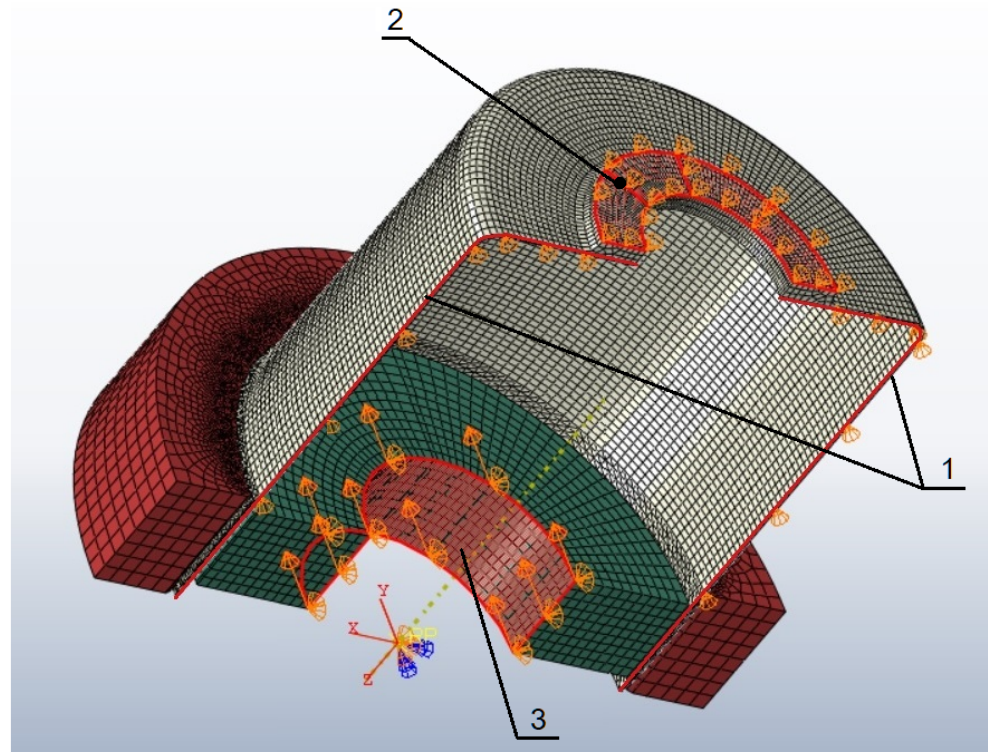
Figure 4. General view of harmonic drive model with finite element mesh and boundary conditions: (1) section plane with displacements allowed only in the XZ plane, (2) fixed bottom of the flexspline, (3) displacements of the wave generator.